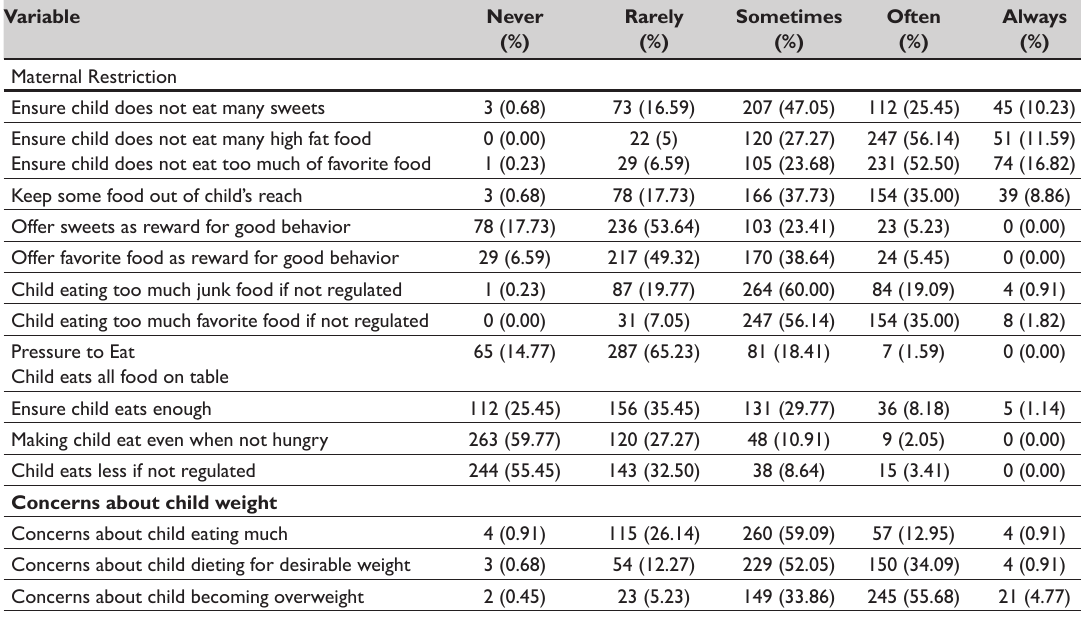
Table 4: Mothers’ Preventive practices against childhood obesity through restriction Variable Never